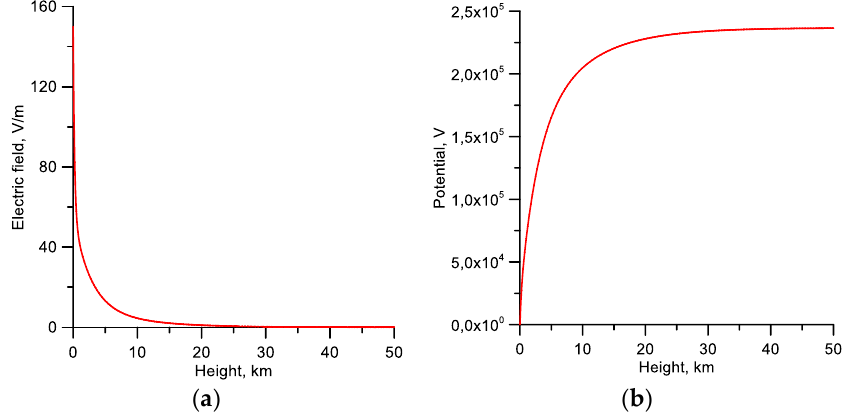
Figure 1. ( a ) The variation of the fair-weather atmospheric electric field with height. ( b ) The variation of atmospheric potential with height.